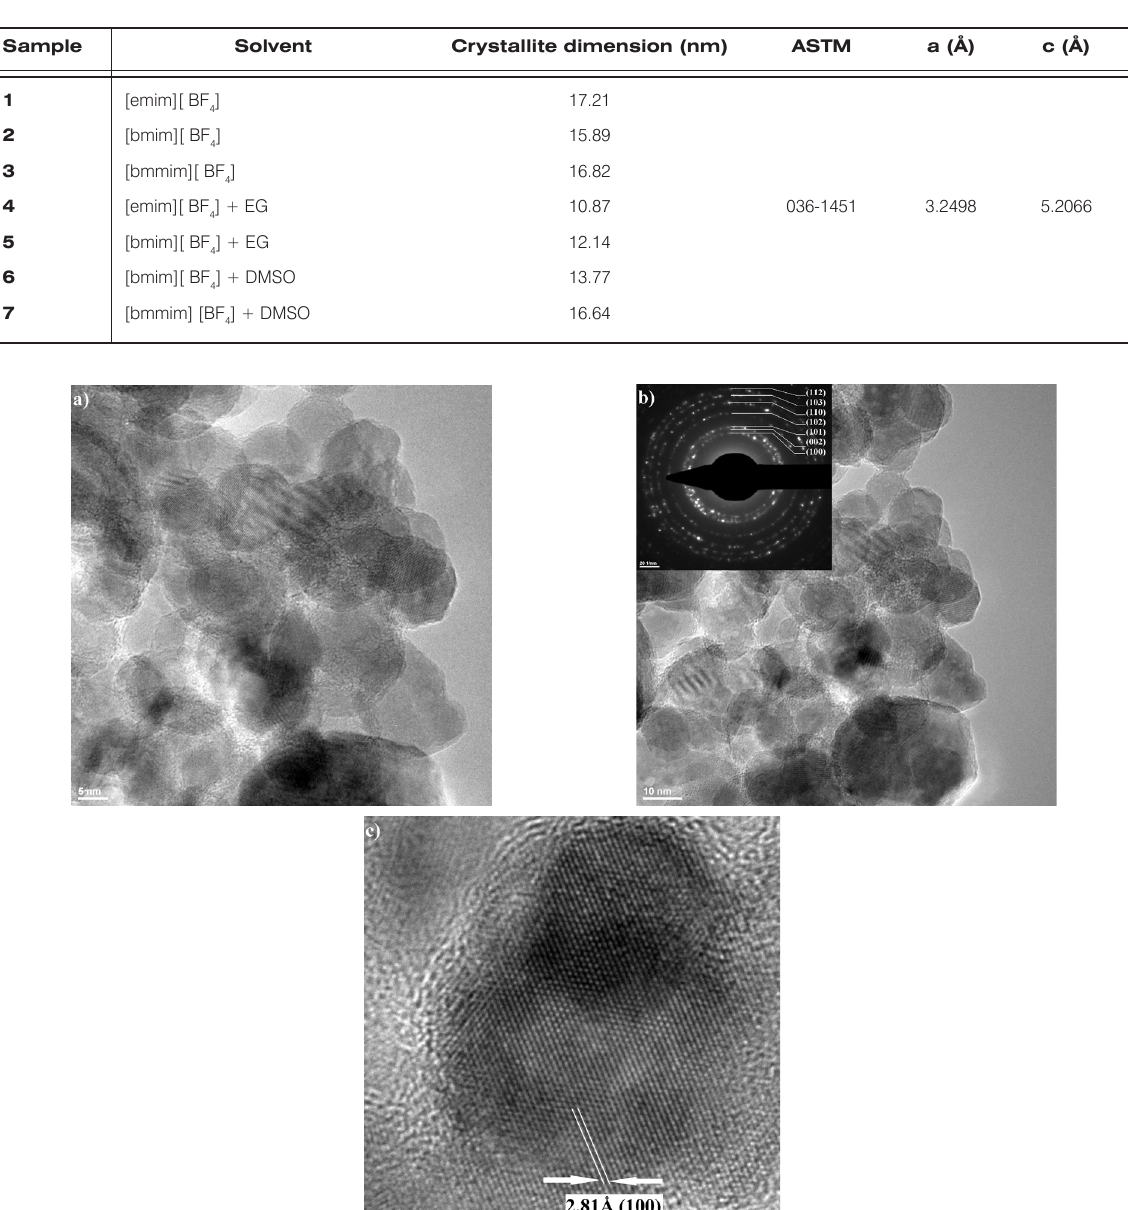
Figure 3. TEM images, SAED patterns and the corresponding HRTEM images for ZnO powders obtained in different media based on ionic liquids - pure [emim][BF 4